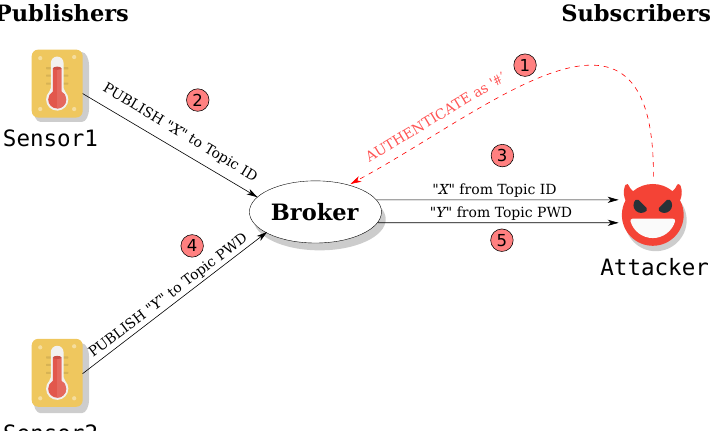
Figure 1. Example of access control vulnerability that allows an attacker to subscribe to all topics and receive all messages being published. The numbers refer to the temporal evolution of the MQTT interactions depicted in the